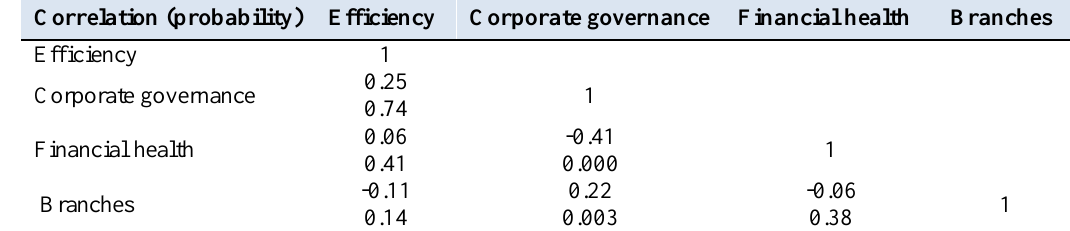
Table 3. Results of correlation between variables